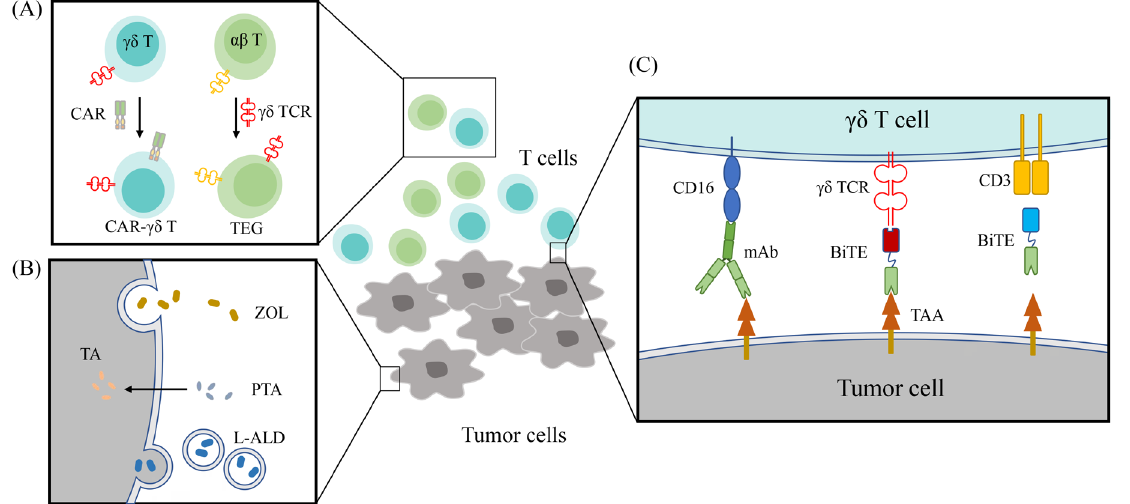
Figure 1. Strategies to improve the anti-tumor effect of γδ T cells. (A) CAR redirected γδ T cells have a better way of recognizing specific tumor cells. αβ T can possess the advantages of recognizing antigens in an MHC-unrestricted manner and a sense of metabolic dysregulation through transfection Vγ9Vδ2 TCR; (B) NBPs are hydrophilic and enter cells through fluid-phase endocytosis. The highly hydrophobic bisphosphonate prodrug, PTA can efficiently permeates cell membranes and be hydrolyzed to active acid form, TA by intracellular esterase to block FDPS. NBPs are delivered using nano-technology; (C) the cytotoxicity of Vγ9Vδ2 T cells against malignant cells increases in the presence of antibodies targeting TAAs. BiTEs targeting γδ T cells and tumor antigens recruit γδ T cells to the tumor